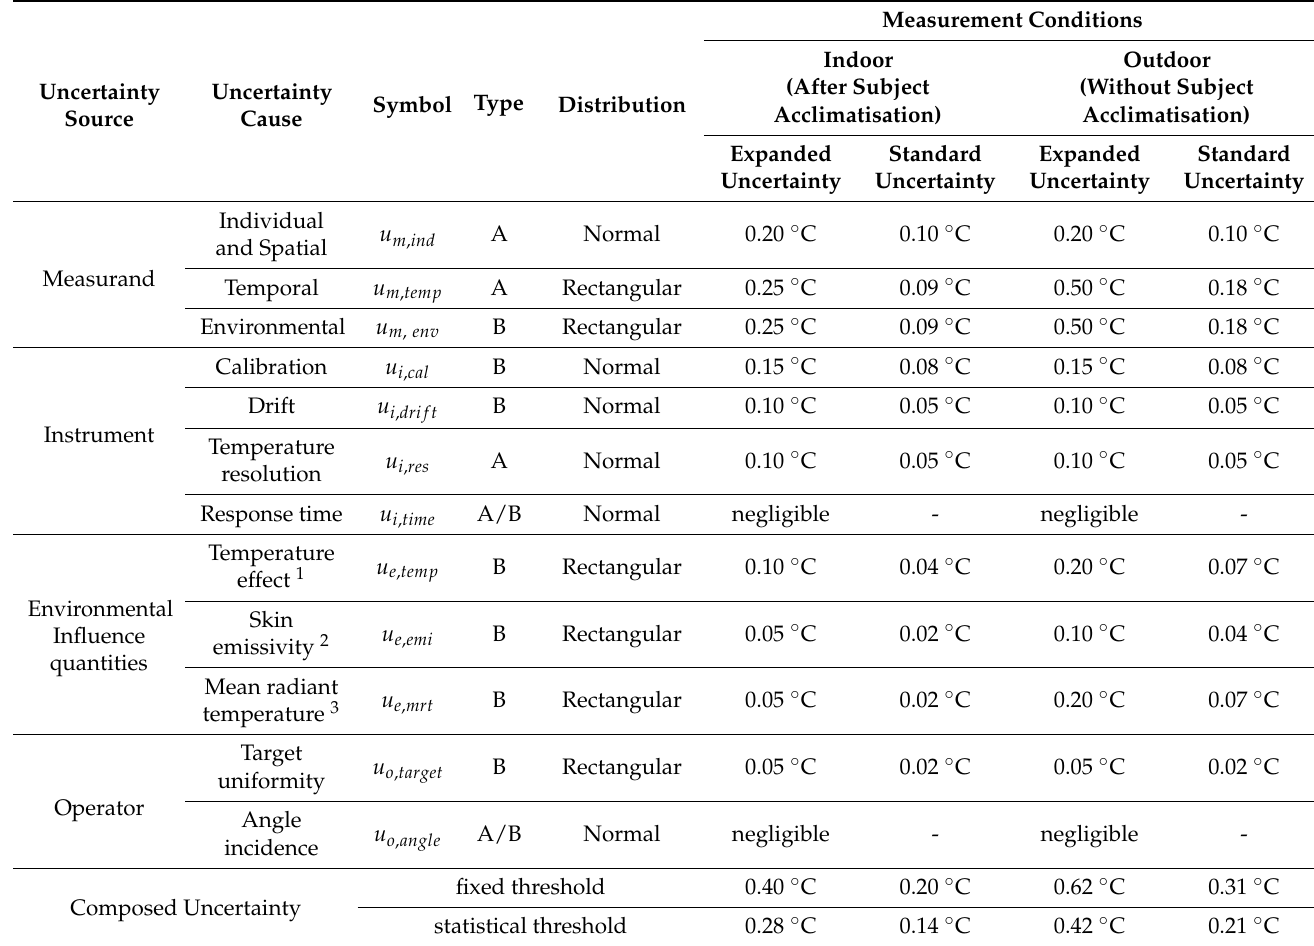
Table 2. Uncertainty budget.